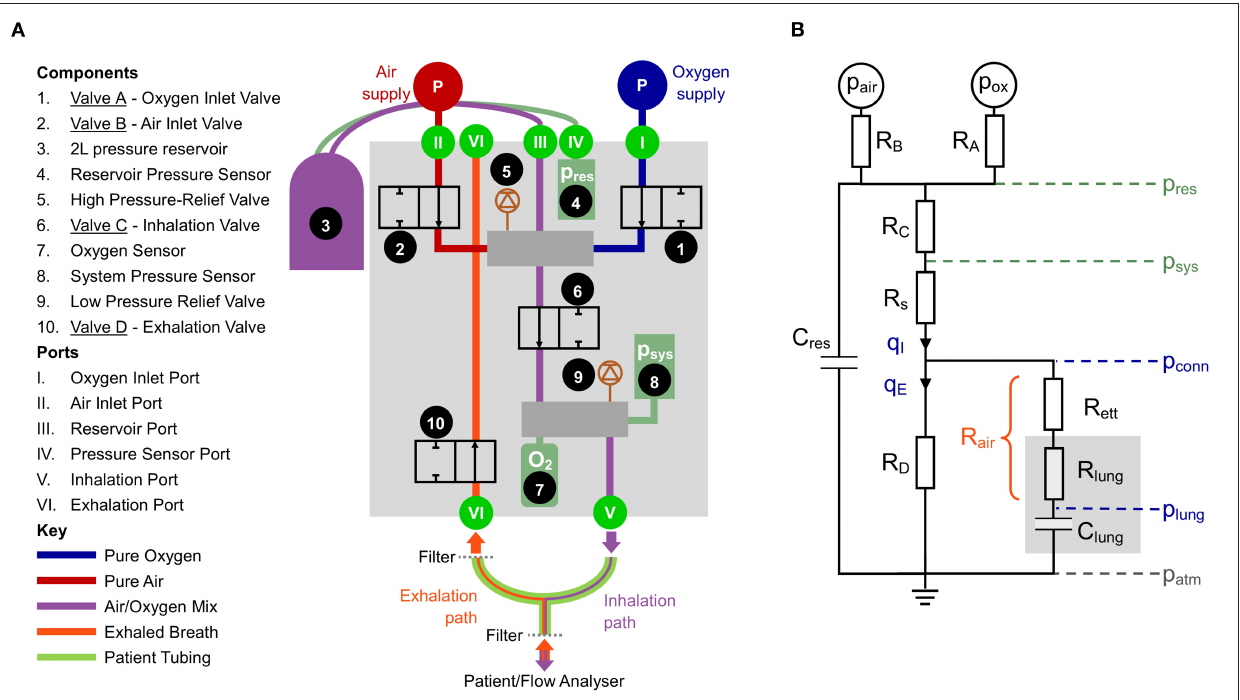
FIGURE 1 | (A) Schematic of the proposed design. (B) Simplified lumped parameter model of the system. Pressures: reservoir pressure (p res ), system pressure (p sys ), pressure at the patient connector (p conn ), pressure in the distal lungs (p lung ). Green indicates measured and blue indicates calculated. Flow rates: q I , inhaled flow, q E , exhaled flow. The resistances represent combined influence of multiple components: R A , oxygen port connections and Valve A; R B , air port connections and Valve B; R C pneumatic pathways between the reservoir and downstream manifold; R D , all pneumatic components in the exhalation pathway; R s , pneumatic components downstream of p sys ; R ett , endotracheal tube; R lung , resistance in the lung, predominantly the upper airways; R air , combination of R ett and R lung , used to estimate p lung .